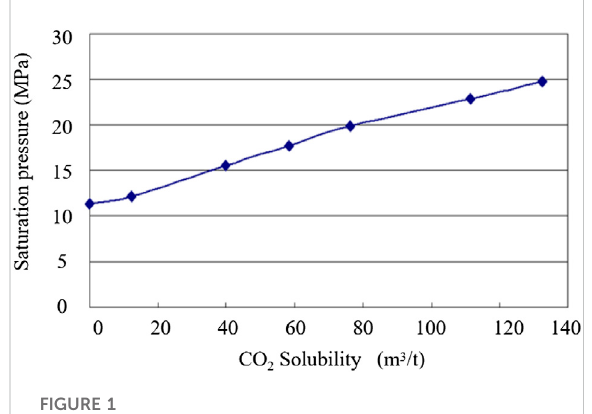
FIGURE 2 Relationship between CO 2 solubility and volume expansion coef fi cient of formation crude oil (125 ° C).